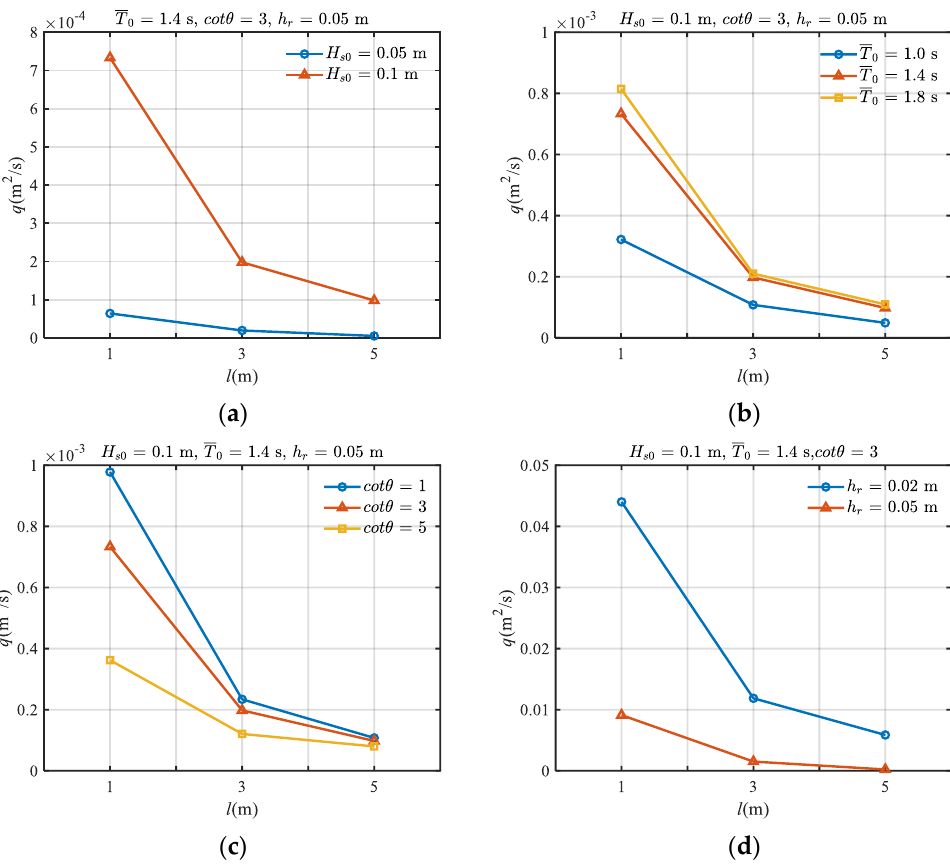
Figure 23. Irregular mean wave overtopping discharge over the sloped seawall for different cases: ( a ) H s 0 ; ( b ) T 0 ; ( c ) cot θ ; ( d ) h r . Table 3. Empirical coefficients for predicting the wave force on the